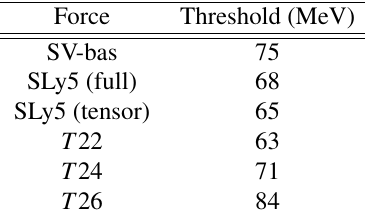
Table 1. Fusion upper threshold energies for the 16 O + 16 O collision using various parametrisations of the Skyrme interaction. For references to interactions, see text. The energies are calculated to the nearest 1